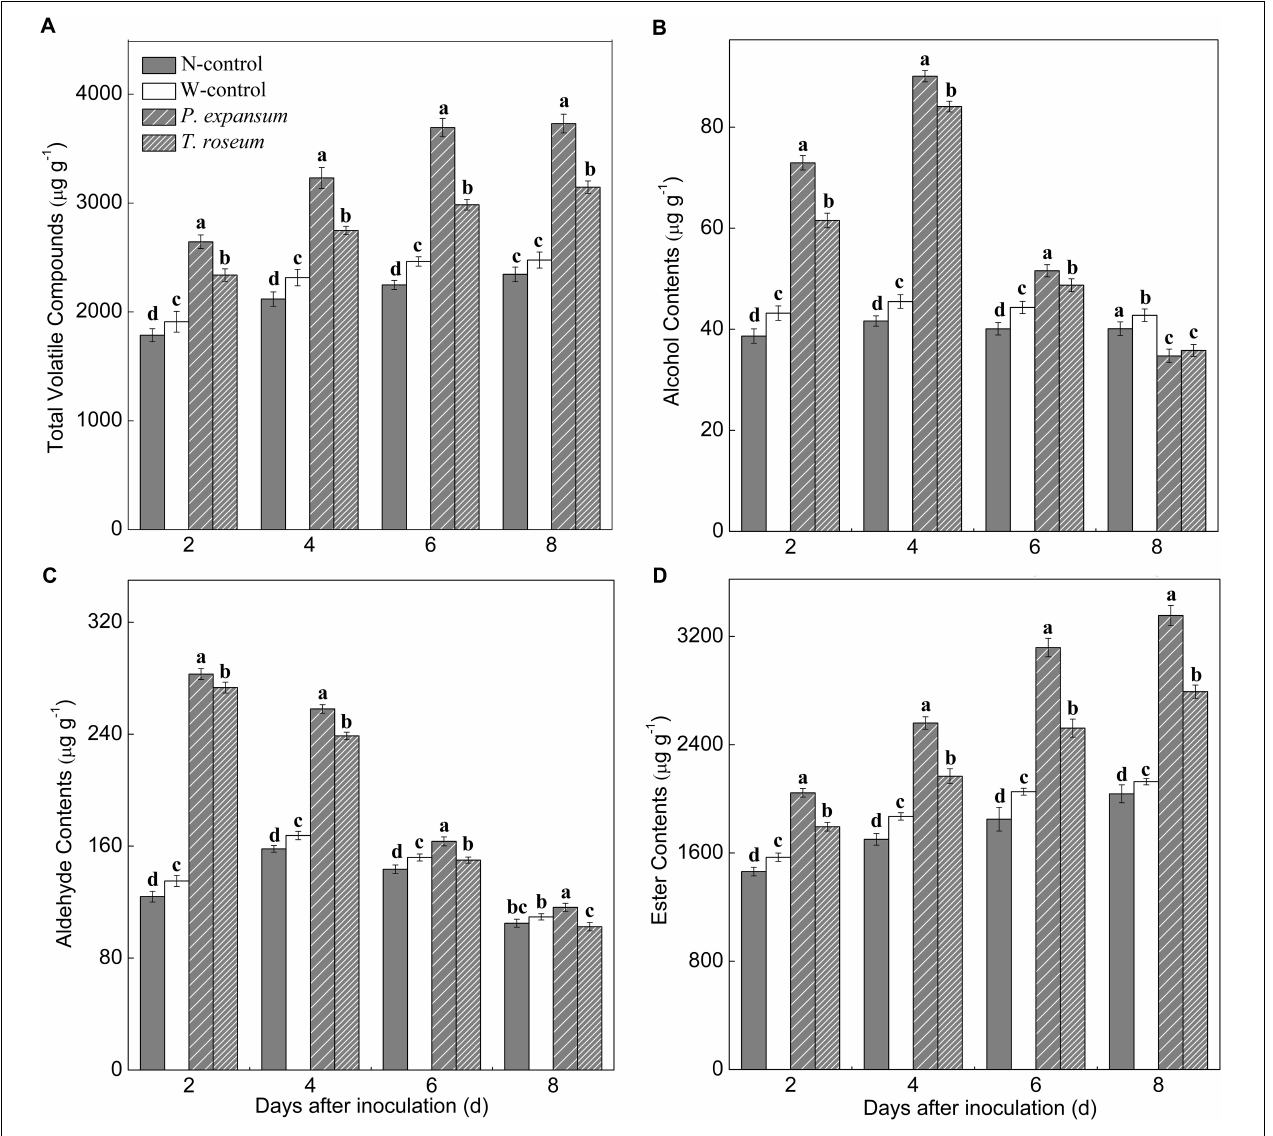
FIGURE 5 | Effects of P. expansum and T. roseum inoculation on contents of total VOCs (A) , alcohol (B) , aldehyde (C) , and ester (D) in apple fruit during storage. All data are expressed as means ± standard deviation of triplicate samples. Different letters indicate significant differences ( P <